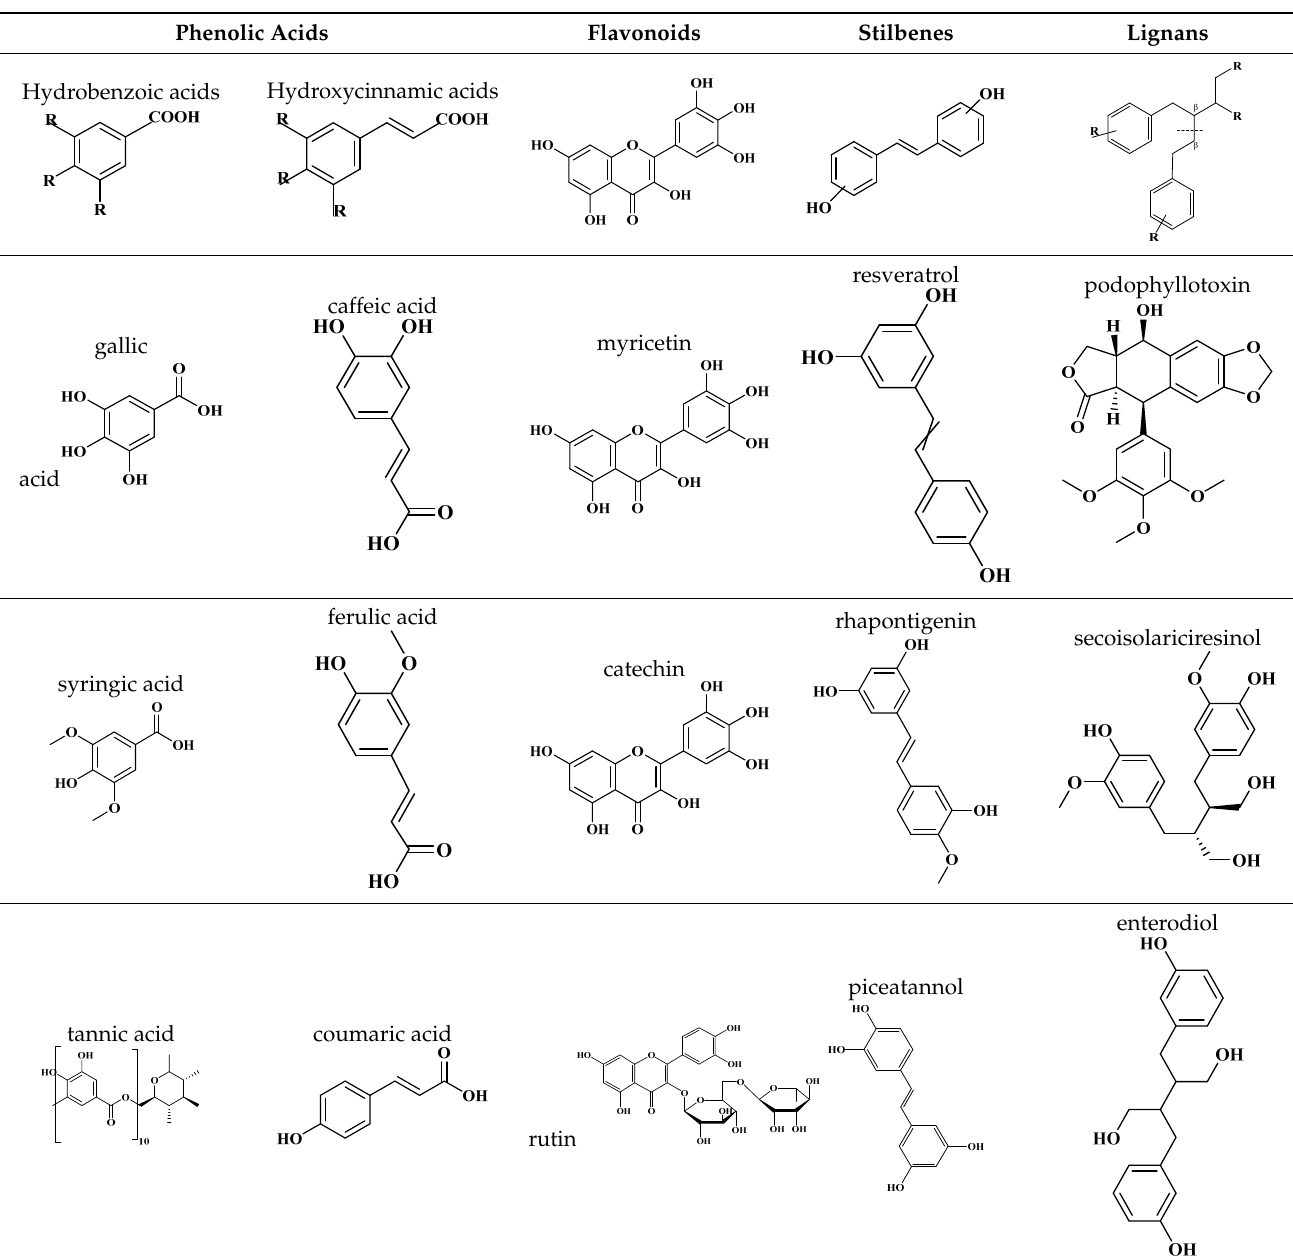
Table 1. Chemical structure of polyphenols and some examples of subgroups of polyphenols.